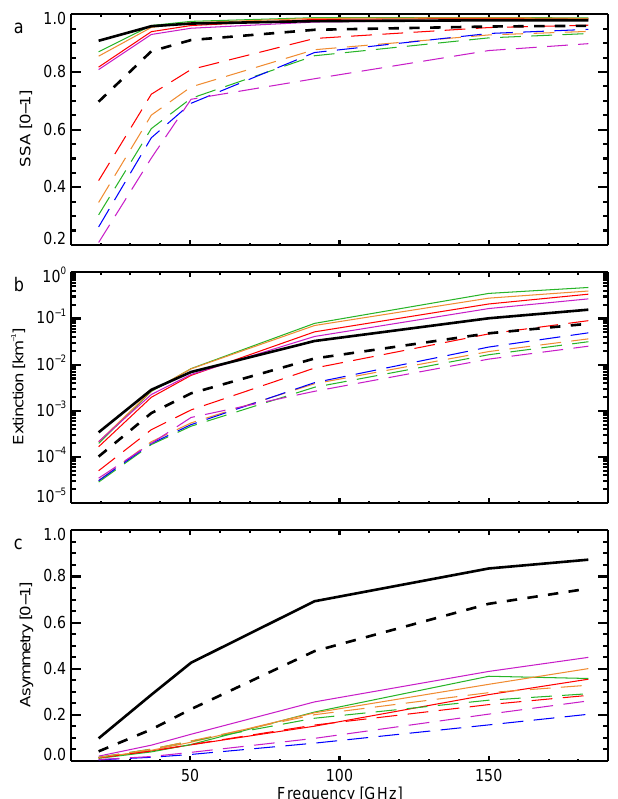
Figure 3. As Fig. 2 but showing bulk optical properties against fre- quency for a snow water content of 0.1gm − 3 . Points are plotted for a selection of SSMIS frequencies: 19.35, 37, 50.3, 91.655, 150 and 183 ±